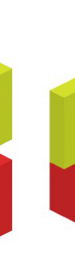
Figure 4: Karbnadi’s main and side rib bricks connection